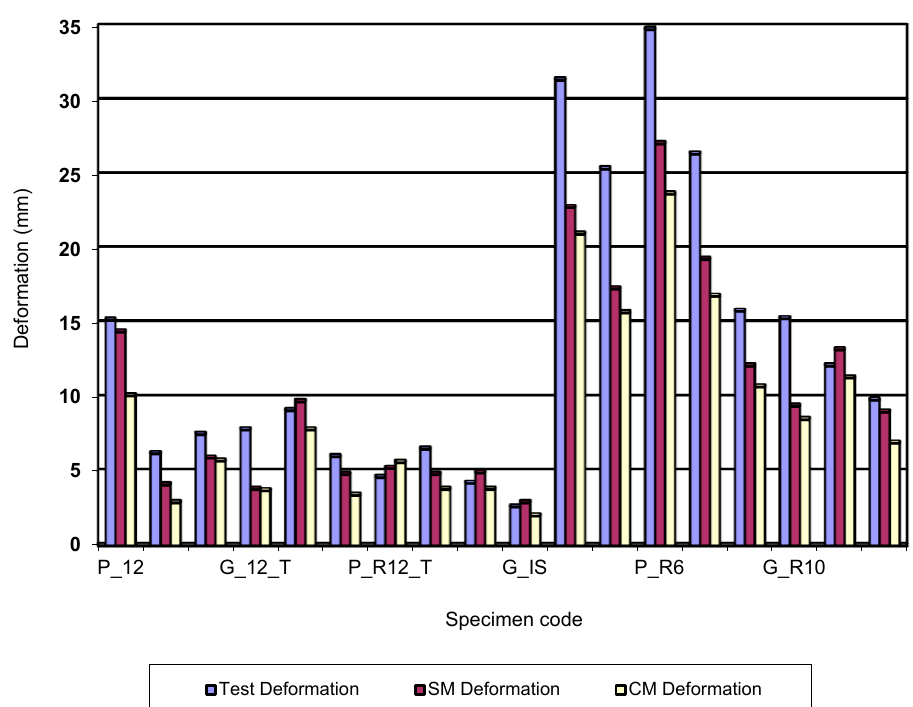
Figure 7. Evolution of the bending total deformation values for 3D printed specimens. The explanation is due to the slender cross sections of the specimens, which do not allow large elastic deformations. In order to understand the cause of the errors, specimens with rectangular cross-sections of the same dimensions but arranged differently were additively manufactured. The specimens have dimensions (height x width) of 10 × 5 and 15 × 6 mm. These specimens were 3D printed under the same conditions (printing parameters were the same). Figure 8 shows the values of Von Mises stresses obtained by simulation for specimens having a rectangular cross section and dimensions of 15 × 6 mm.